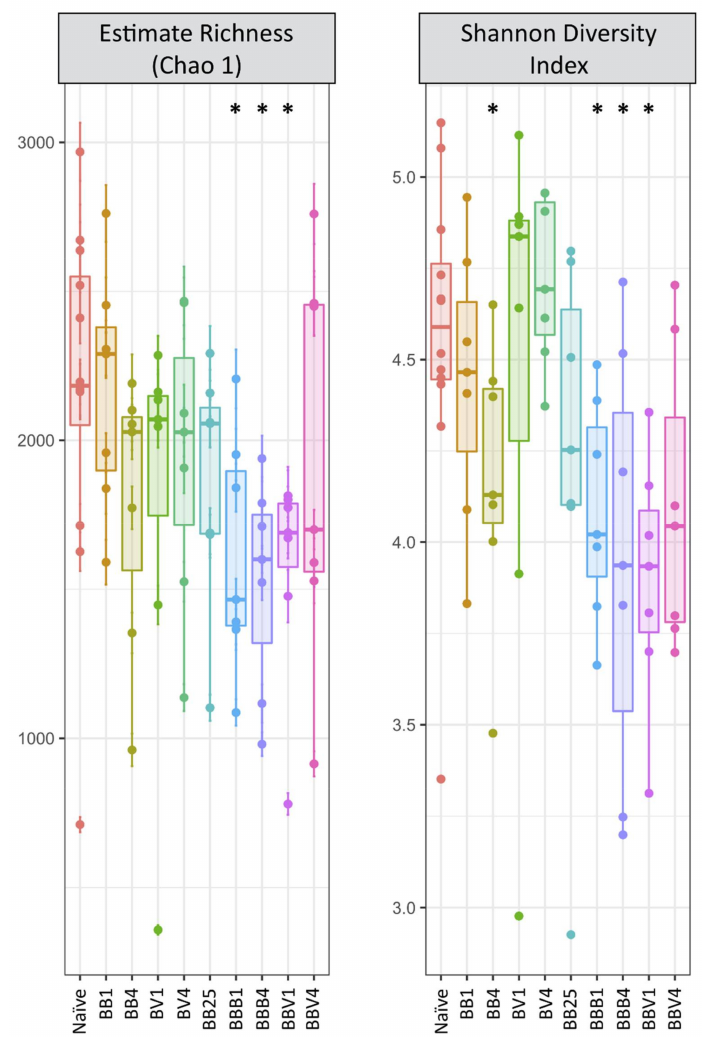
Figure 3. Microbiota alpha Diversity: Boxplots of Chao1 and Shannon indices for all samples. For the Naive condition, B0 and B25 snails were pooled; BB: primary infection of BgBRE by SmBRE; BV: primary infection of BgBRE by SmVEN; BBB: primary infection of BgBRE by SmBRE and secondary challenge by SmBRE; BBV: primary infection of BgBRE by SmBRE and secondary challenge by SmVEN. The time point is mentioned with 1, 4 or 25 corresponding to the day after primary infection or secondary challenge. The differences between naive and infected conditions were tested with a Mann–Whitney U test and significant differences mentioned with